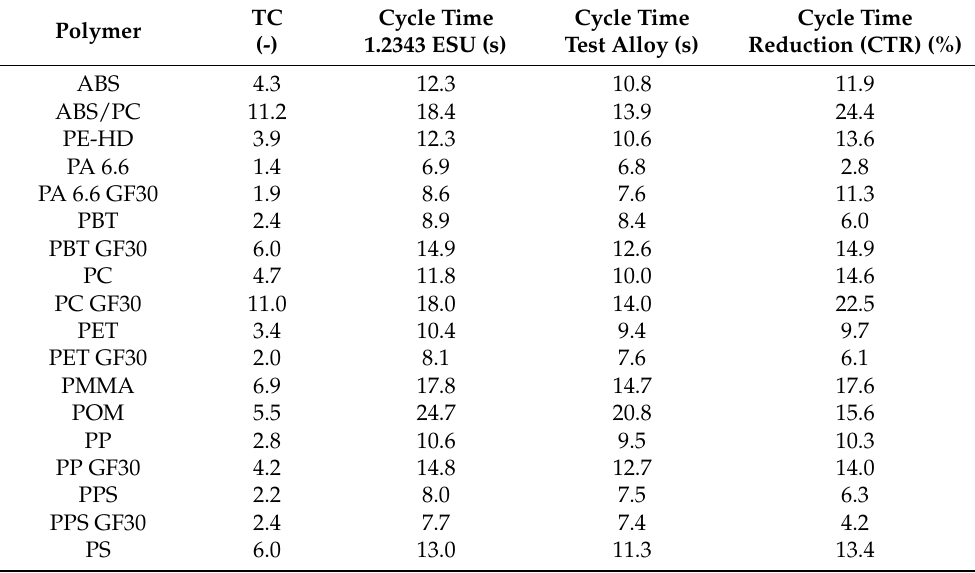
Table A1. Temperature coefficient (TC), cycle times, and cycle time reduction (CTR) for the investi- gated polymers for 1 mm part thickness.